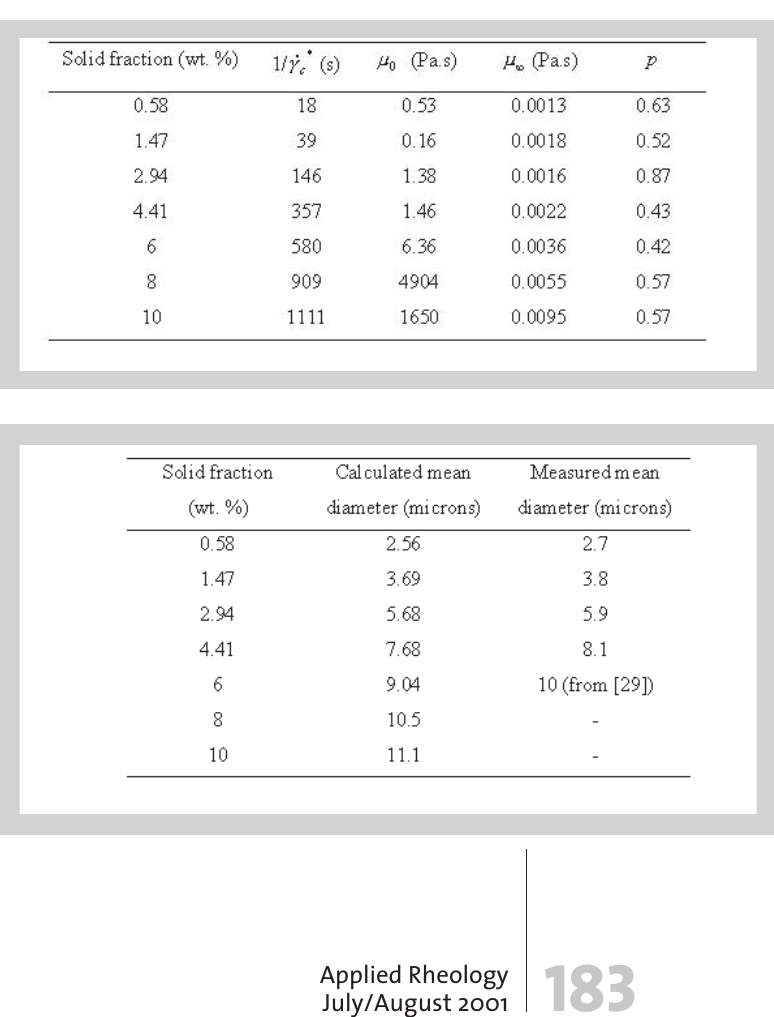
Table 3 (above): Parameters of the Quemada model obtained by fitting the experimental data. Table 4 (below): Mean particle diameter calculated with Eq. (7) and comparison with experimental